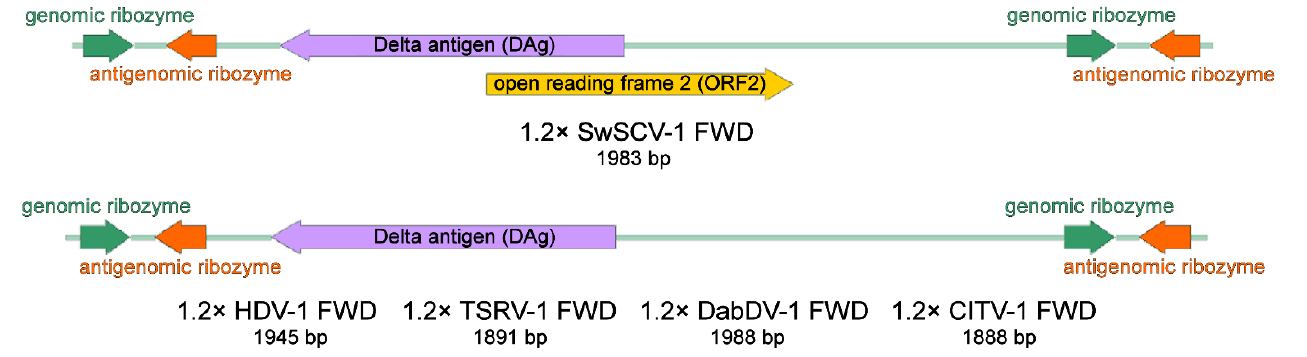
Figure 1. Schematic representation of the “1.2× genome” kolmiovirid inserts in forward (FWD)/genomic orientation. We cloned the 1.2× genome of the displayed kolmiovirid: Swiss snake colony virus 1 (SwSCV-1, GenBank accession: NC_040729.1, 1.15× genome), human hepatitis D virus genotype 1 (HDV-1, M21012.1, 1.16× genome), Tome’s spiny rat virus 1 (TSRV-1, MK598005.2, 1.13× genome), Dabbling duck virus 1 (DabDV-1, NC_040845.1, 1.17× genome), and Chusan Island toad virus 1 (CITV-1, MK962760.1, 1.22× genome) into pCAGGS/MCS plasmid, both in genomic (FWD— shown in this figure) and in antigenomic (REV) orientation. Each of the inserts, approximately 1.2× of the genome size, contains a single copy of the genomes flanked from each end by both the genomic and antigenomic ribozymes. The images were created using SnapGene Viewer (https://www.snapgene.com/snapgene-viewer/; accessed on 14 October 2019).